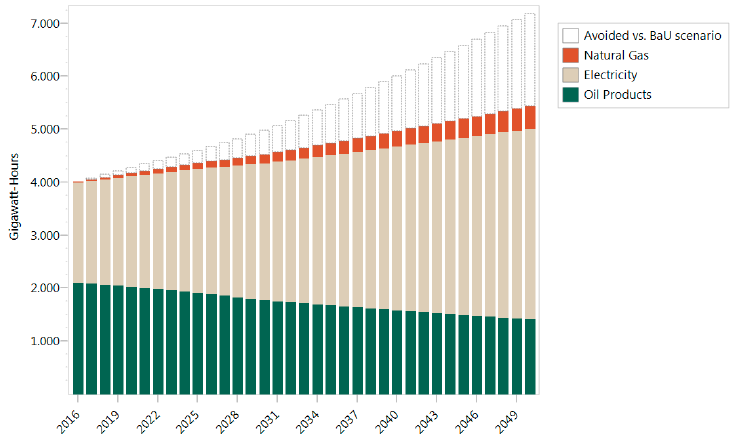
Figure 4. Energy consumption of the intervention replication scenario of